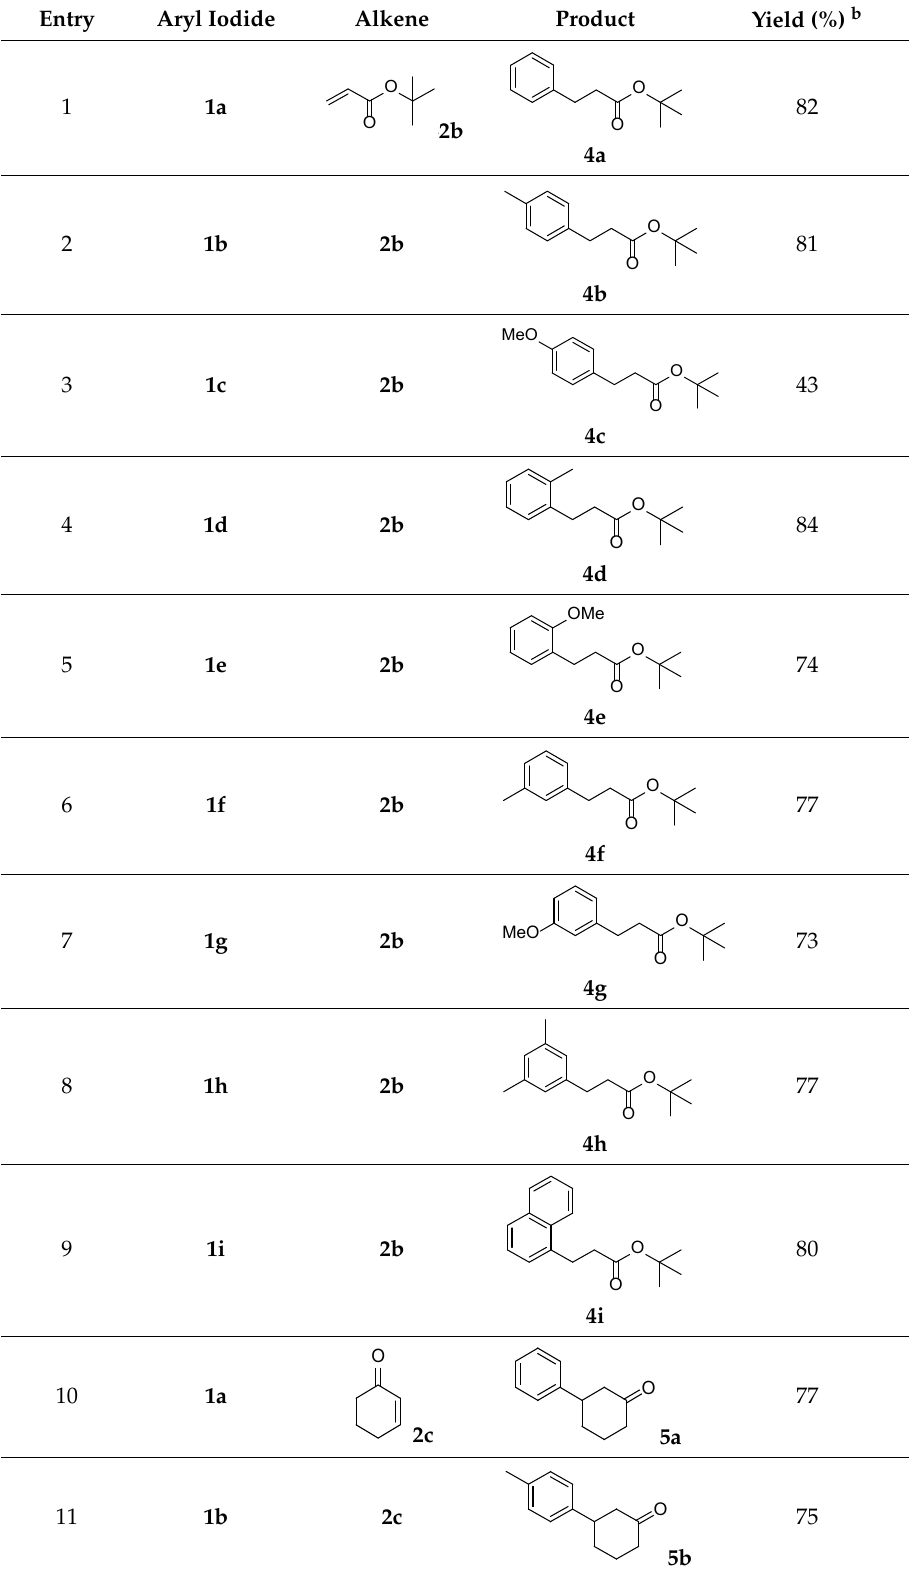
Table 3. Iron-catalyzed conjugate addition of aryl iodides ( 1 ) onto activated alkenes ( 2 ) a . Entry Aryl Iodide